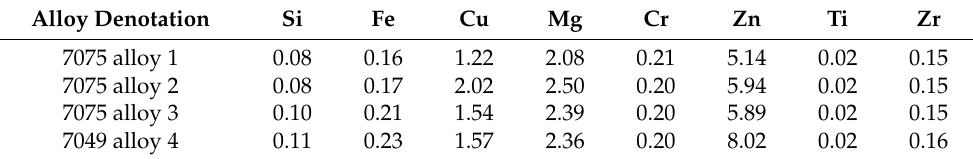
Table 1. The chemical composition of investigated alloys, mass percentage. Alloy